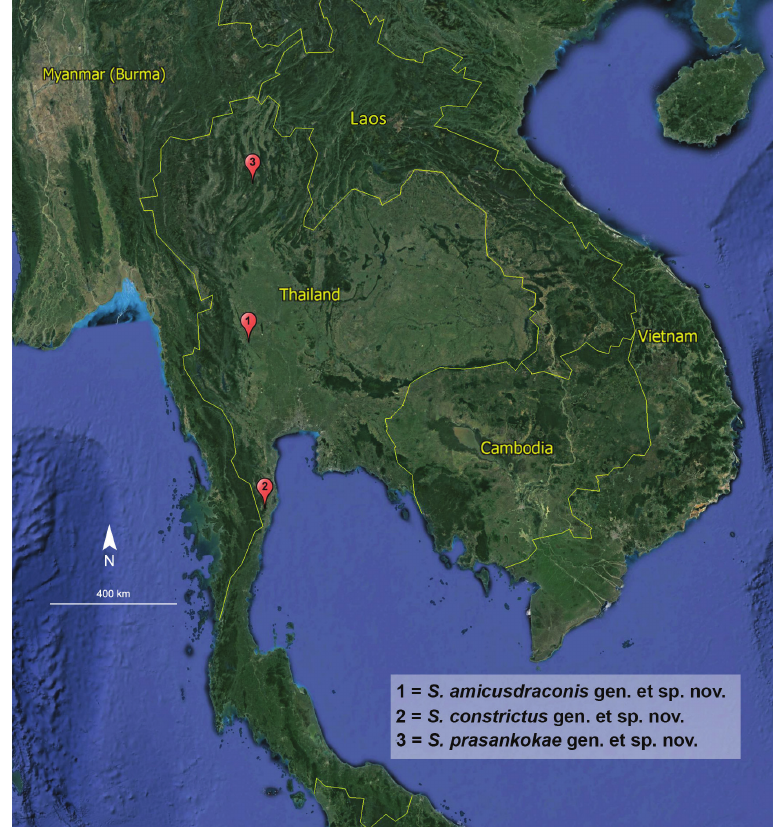
Figure 7. Geographic location of the type localities of Siliquobolellus gen. nov.